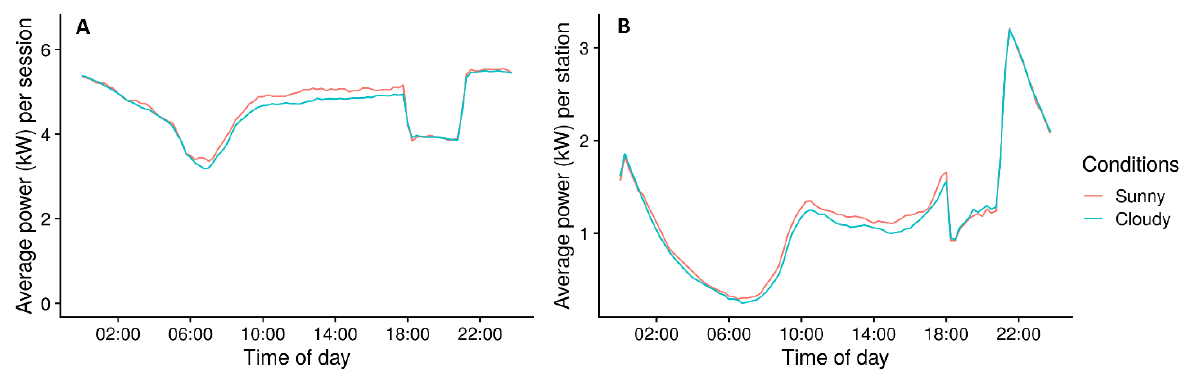
Figure 5. The average power per active session (A) and per station (B) over the day for different weather conditions.